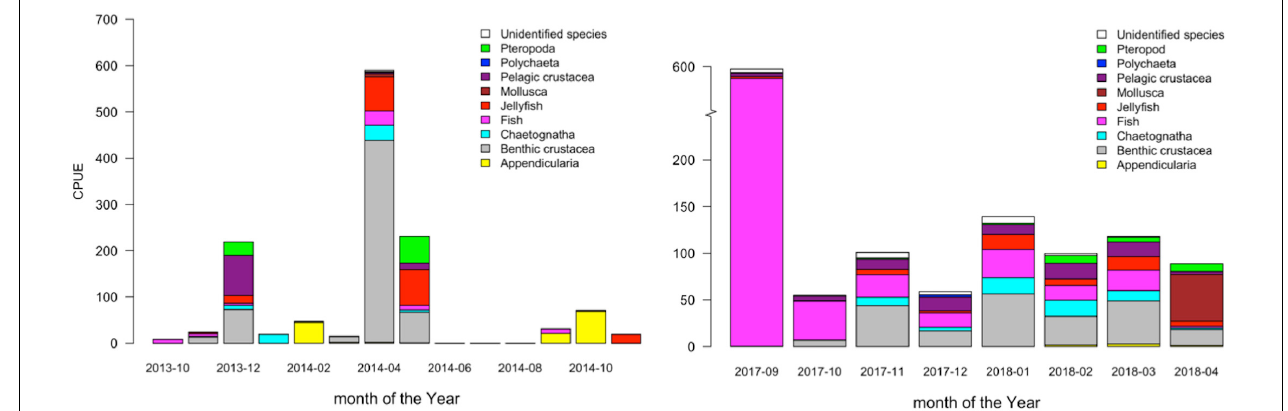
FIGURE 7 | Data from the RemOs1 stereoscopic fish observatory attached to the underwater node system in Kongsfjorden. Left panel: Year round survey from October 2013 to November 2014 (modified after, Fischer et al., 2017). CPUE (catch per unit effort) is an arbitrary unit showing the total mean number of specimen counted per week based on 48 stereoscopic image pairs (one image pair every 30 min) summed up per week. Right panel: The same analysis performed for the period September 2017 to April 2018.